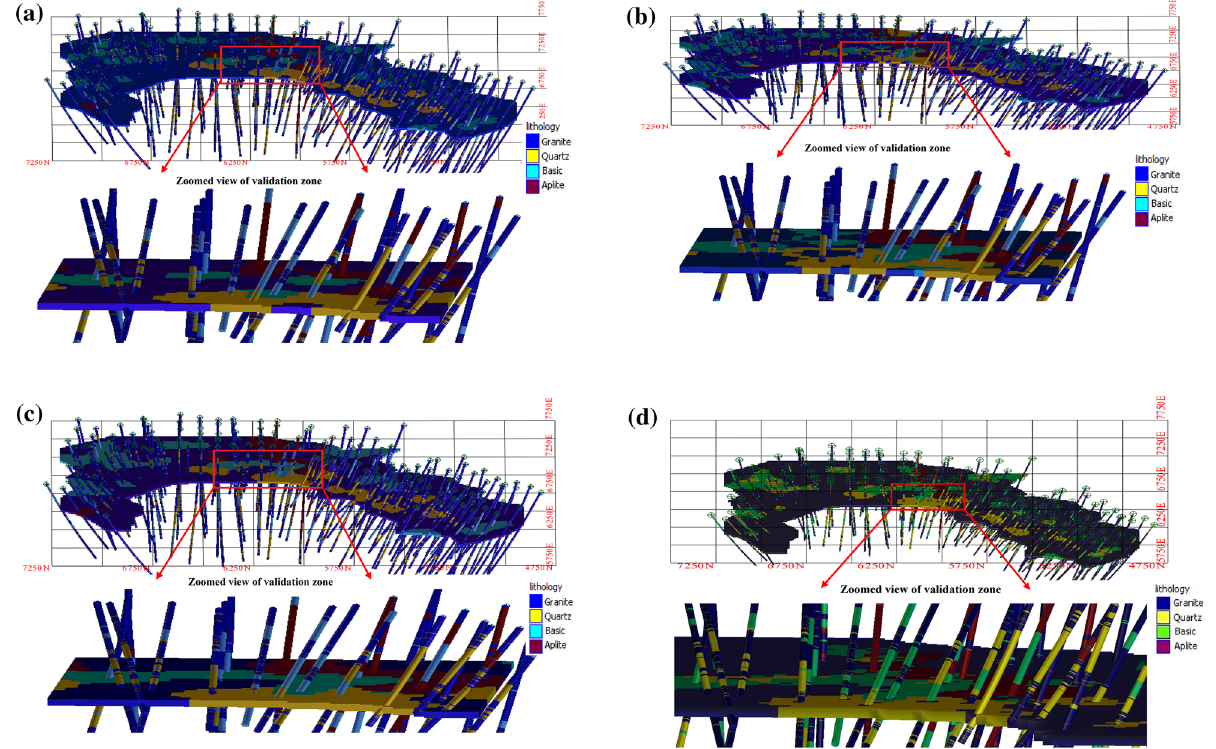
Figure 11. ( a ): Visual examination of MPL maps using Gaussian copula-based simulation. ( b ) Visual examination of MPL maps using t copula-based simulation. ( c ) Visual examination of MPL maps using v-transformed copula-based simulation. ( d ) Visual examination of MPL maps using sequential indicator